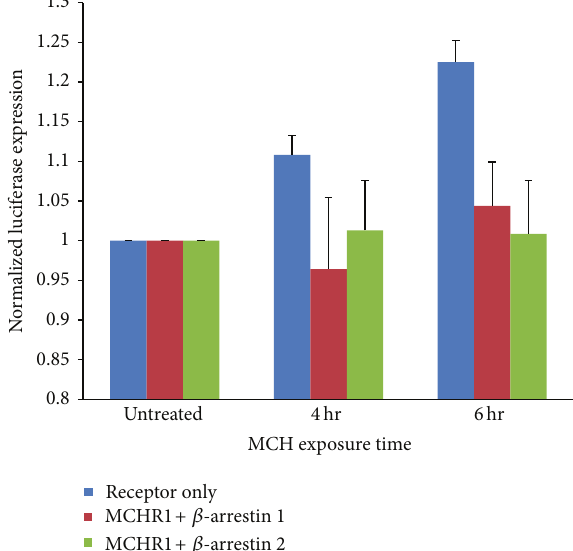
Figure7: 𝛽 -arrestinsdiminishtheactivationofaleptinpromoterby MCH. BHK 570 cells triple transfected with either (1) MCHR1/p(- 762)ob luc/GFP in pcDNA3, (2) MCHR1/p(-762)ob luc/GFP- 𝛽 - arrestin 1, or (3) MCHR1/p(-762)ob luc/GFP- 𝛽 -arrestin 2 were treated with 1 𝜇 M MCH for up to 6 h. A luciferase assay was then performed to quantifiably measure the activation of the leptin promoter. 𝑛 = 5 for control and 𝑛 = 3 for each 𝛽 -arrestin experiment. Graph shows averages of normalized data ± SEM. Experiment reached the 85% ( 𝛽 -arr2) and 90% ( 𝛽 -arr1) confidence intervals but did not reach statistical